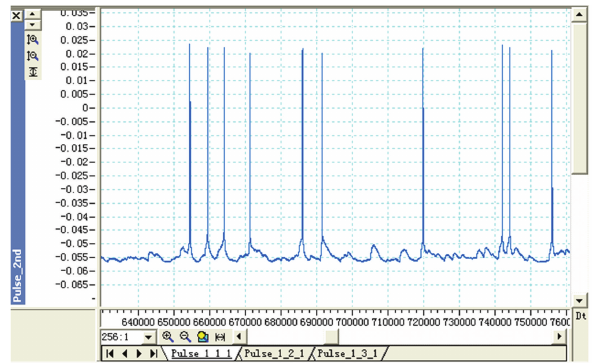
Figure 3: A sample of spike wave (whole-cell recording) visual- ization in PCDReader. The spike waves are for the spontaneous discharges (recorded in the second trace) in hippocampus slice CA1 region pyramid neuron (Wistar Rat). The data was acquired from HEKA instruments in our laboratory.